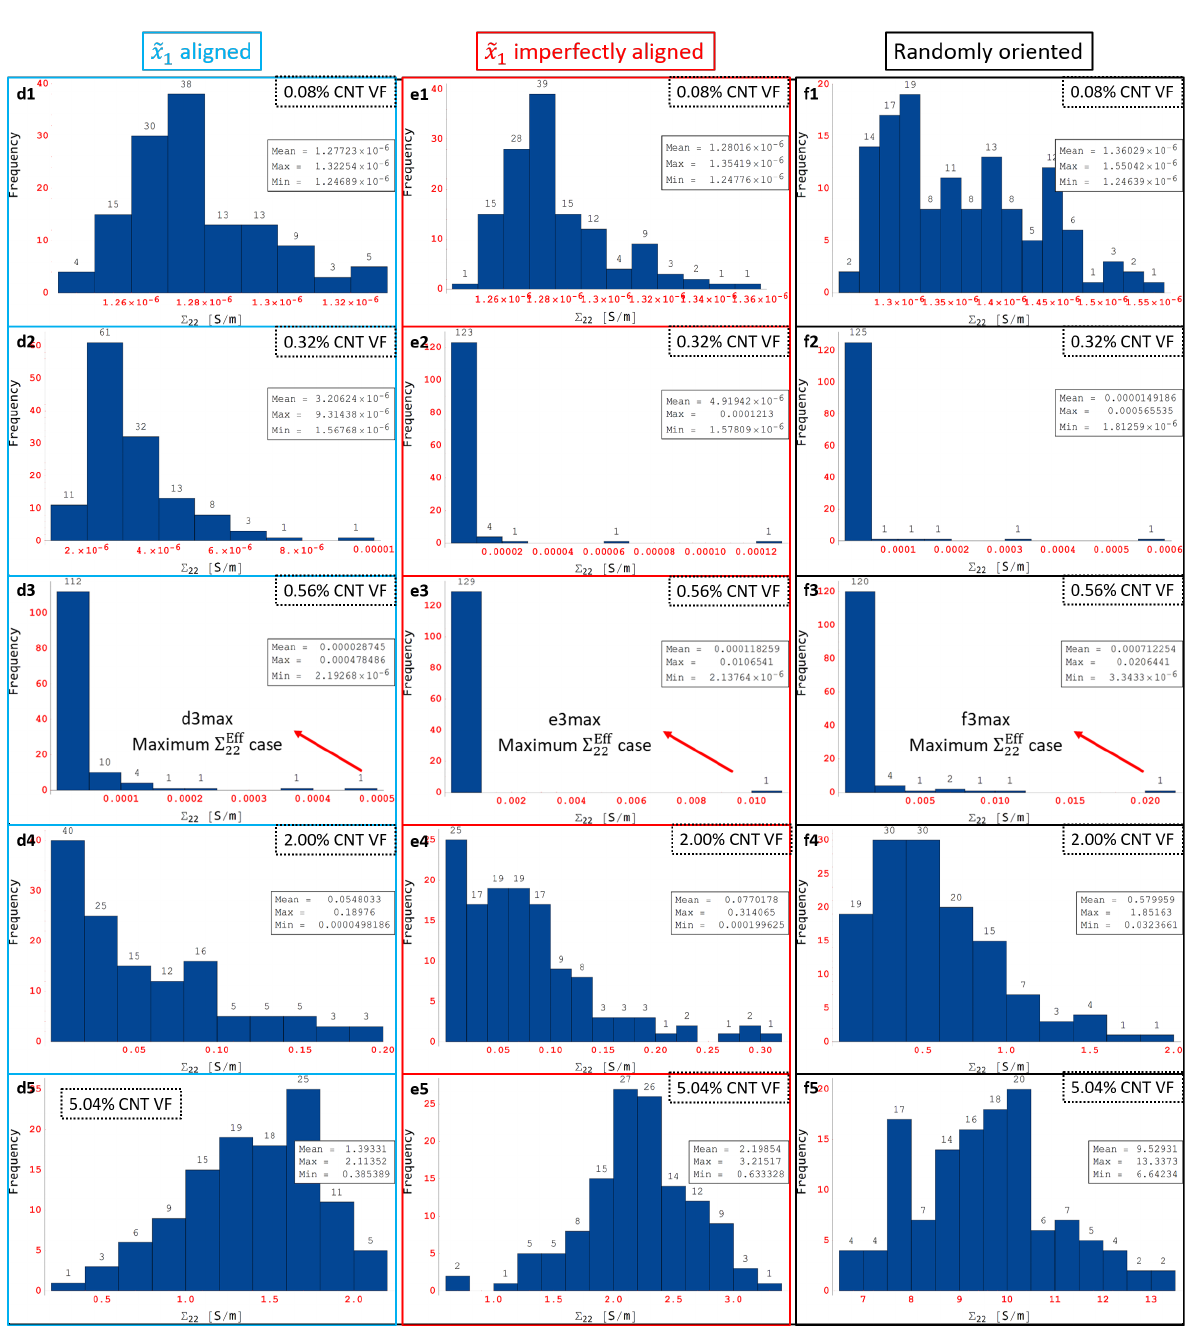
Figure 18. Histograms for Σ 22 at 0.08%, 0.32%, 0.56%, 2.00% and 5.04% CNT volume fractions for all orientation